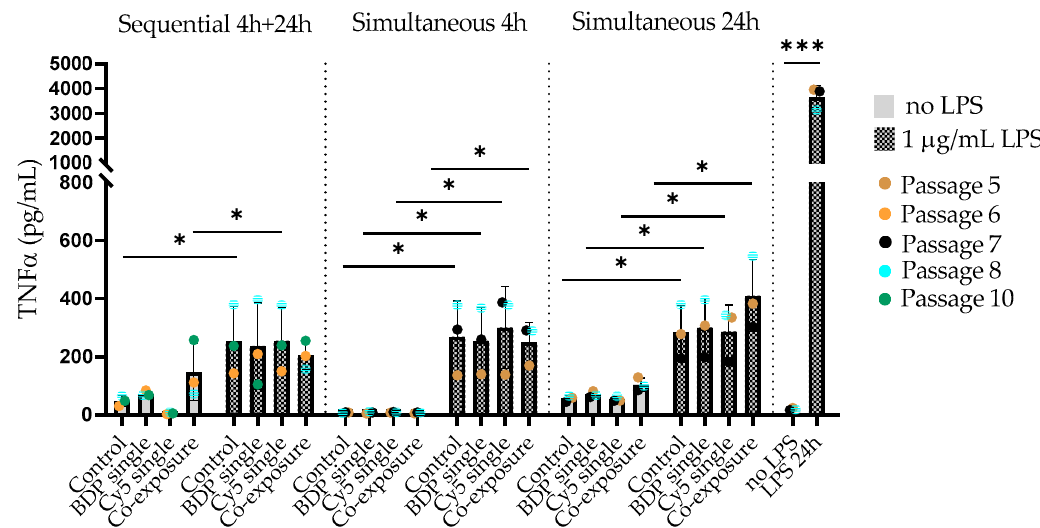
Figure 4. J774A.1 cells were prestimulated with 1- µ g / mL LPS and post-exposed to SiO 2 particles or only exposed to particles. To investigate the production or release of tumor necrosis factor alpha (TNF- α ) in the cell culture media, we collected the supernatants and performed an enzyme-linked immunosorbent assay (ELISA). We have observed a significant increase in TNF- α production in the supernatants of LPS prestimulated cells compared to unstimulated cells (* p < 0.05 and *** p = 0.0002).